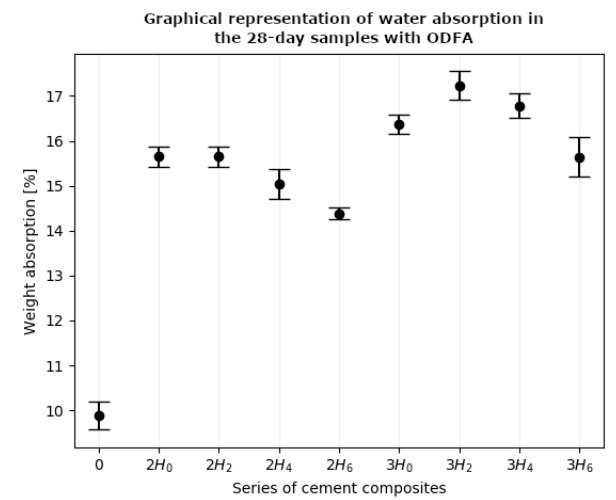
Figure 11. Water absorption data of the 28-day series of composites.